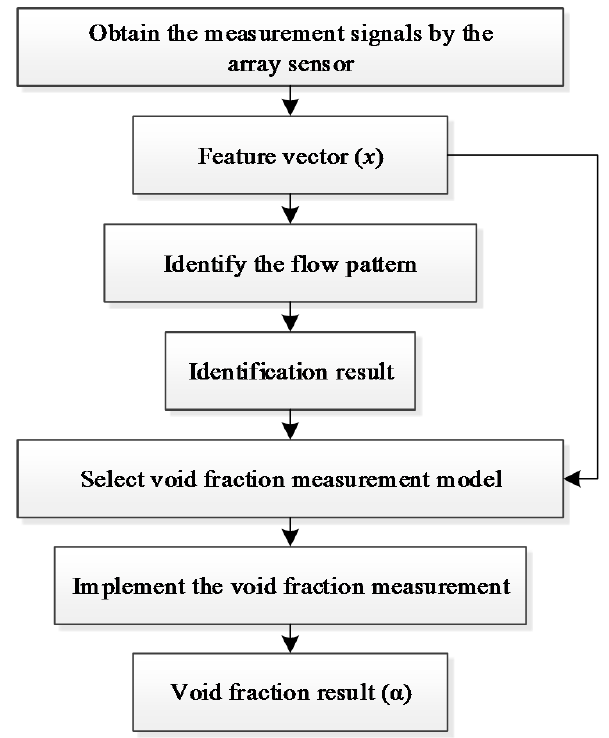
Figure 6. The practical process of the void fraction measurment.